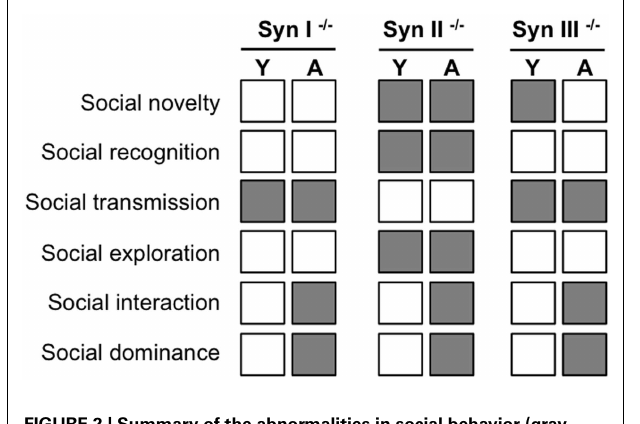
FIGURE 3 | Human mutations in SYN1 and SYN2 associated with epilepsy and/orASD . Nonsense and missense mutations are indicated in blue and black, respectively together with the associated pathology (E, epilepsy; ASD, autism spectrum